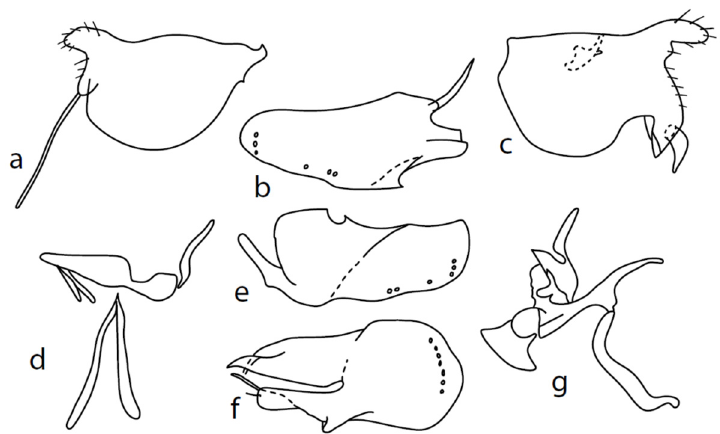
Figure 6. M. turcicus sp. nov.: ( a ): right epandrial lamella, ( b ) = hypandrium from left, ( c ) = left epandrial lamella, ( d ) = postgonites, ( e ) = hypandrium from right, ( f ) = hypandrium ventral view, ( g ) = phallus from left.